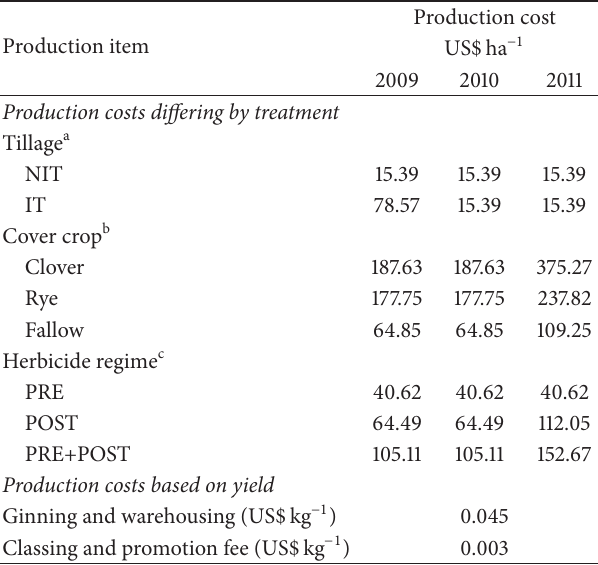
Table 3: Production costs (US$ ha −1 ) for cotton production by